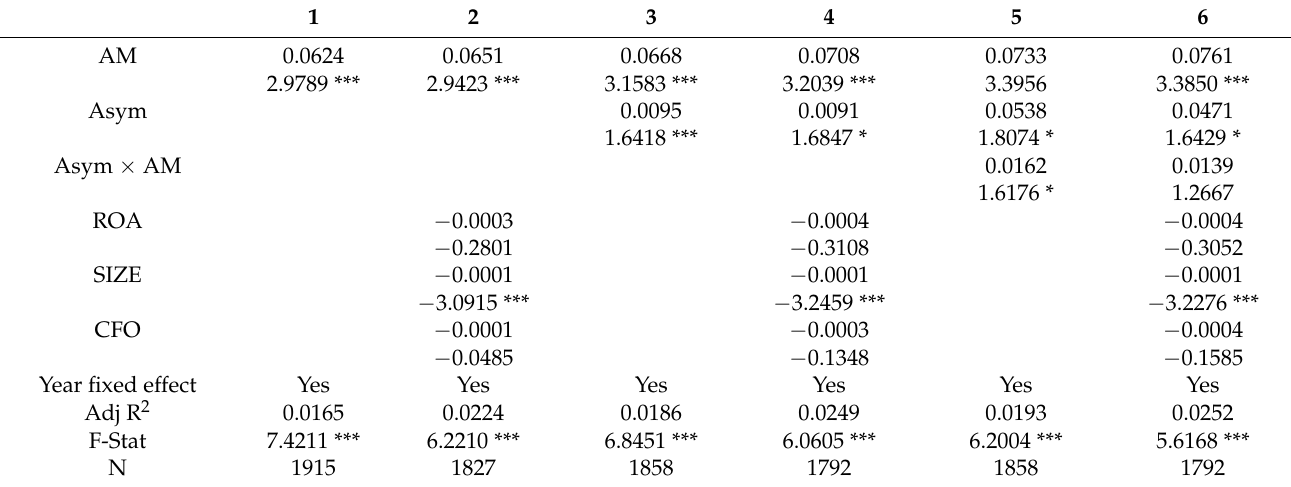
Table 7. The Impact Accrual Management on Firm-Specific Risk (FAMA Discretionary